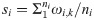
Medical sciences Likert chart: 720 respondents. The number of responses less than zero on the x-axis include almost never (ω0), sometimes (ω1) and half of the often (ω2) responses. The number of responses greater than zero include almost always (ω4), usually (ω3), and half of the often responses. The mean scores on the y-axis are si=Σ1niωi,k/ni. si varies from a low of 0.7 (troubleshooting) to a high of 3.8 (drafting).